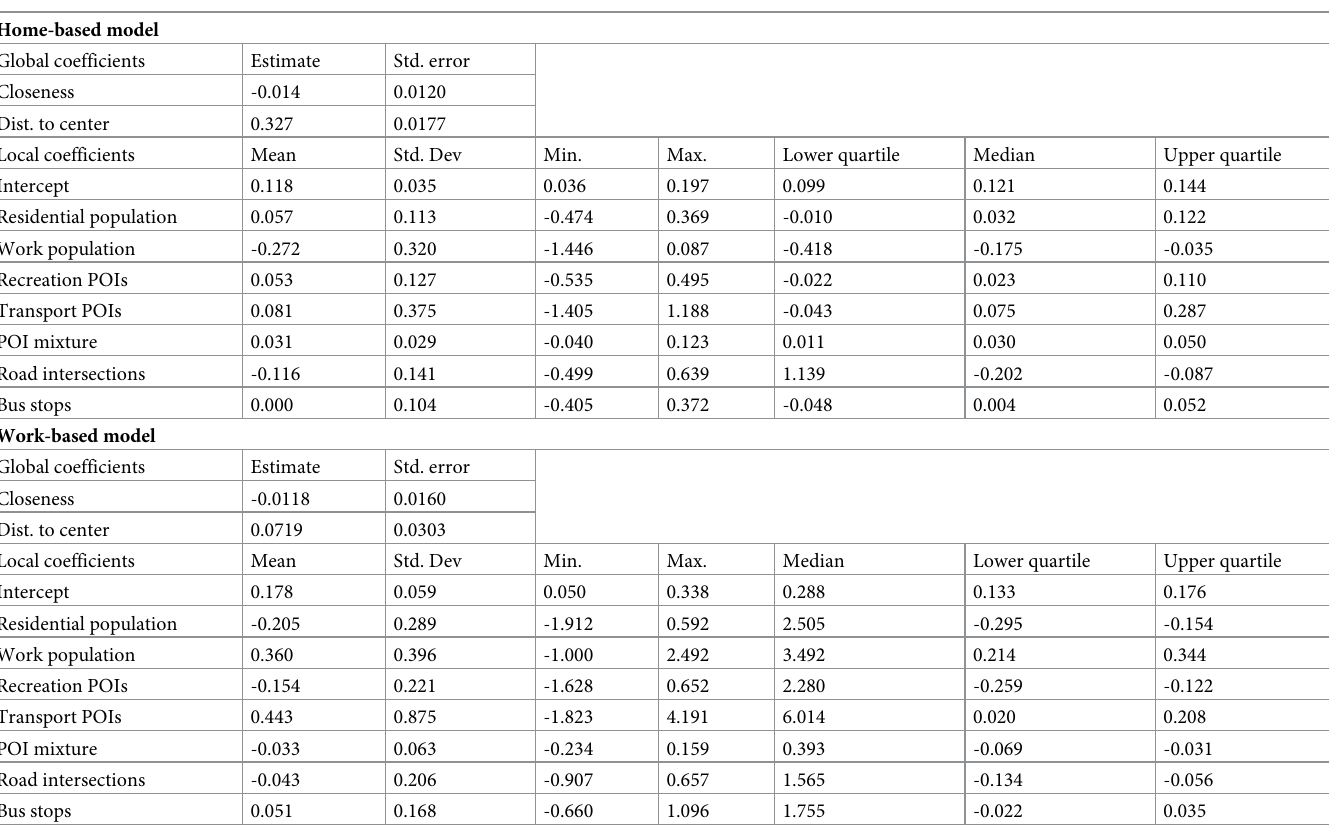
Table 3. Parameter estimation in GWR